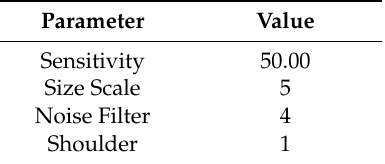
Table 2. Parameters used in Image Labs software for band detection